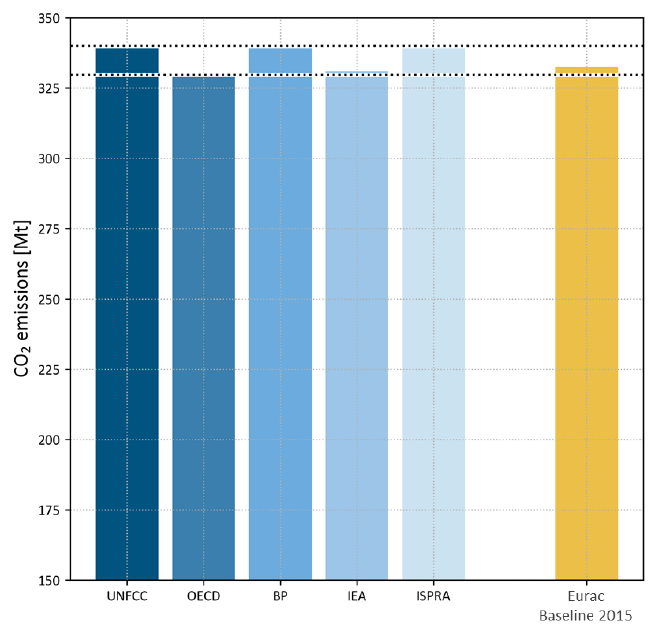
Figure 4. Comparison of annual CO 2 emissions between the value obtained through simulation in the Baseline 2015 and those given by other different sources: UNFCCC [63], OECD [64], BP [65], IEA [62] and ISPRA